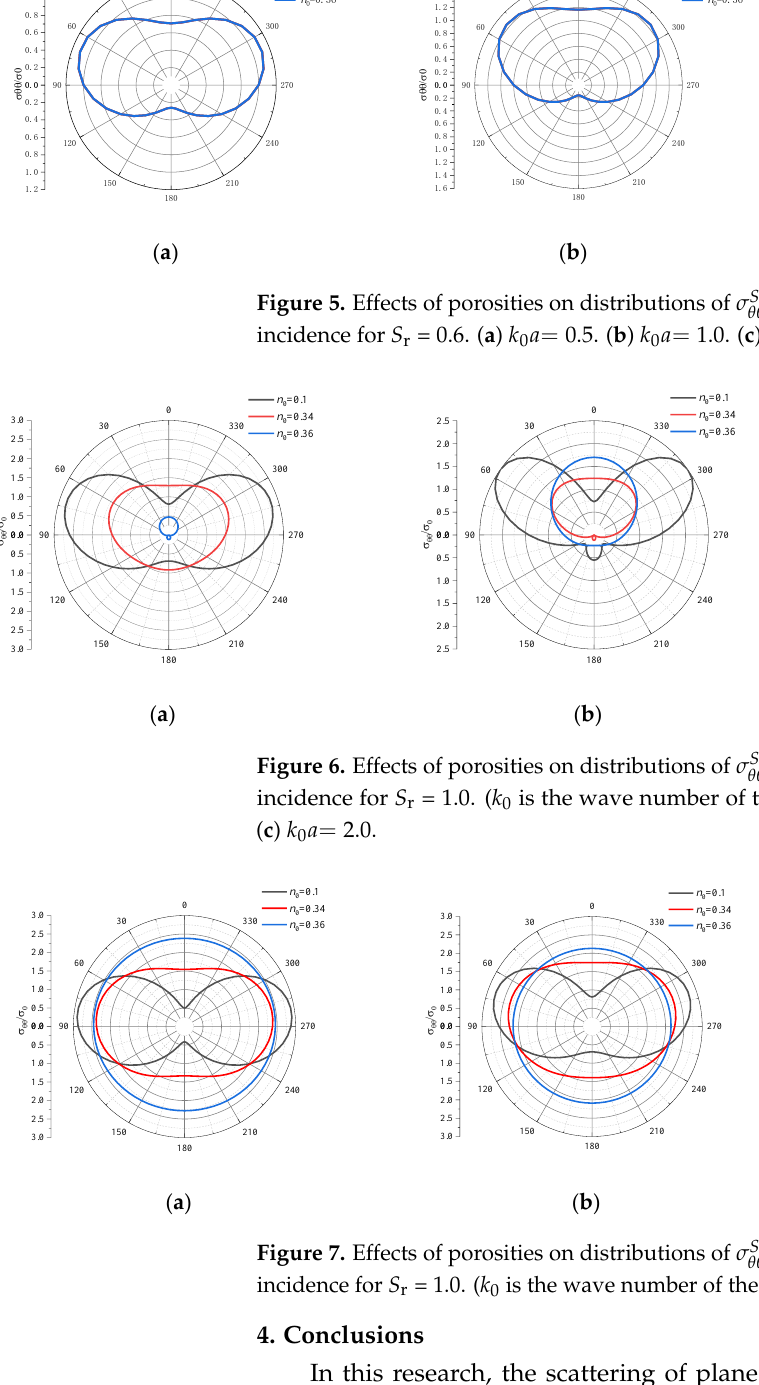
Figure 7. Effects of porosities on distributions of σ S incidence for S r = 1.0. ( k 0 is the wave number of the SV wave). ( a ) k 0 a = 0.5. ( b ) k 0 a = 1.0. ( c ) k 0 a = 3.0.